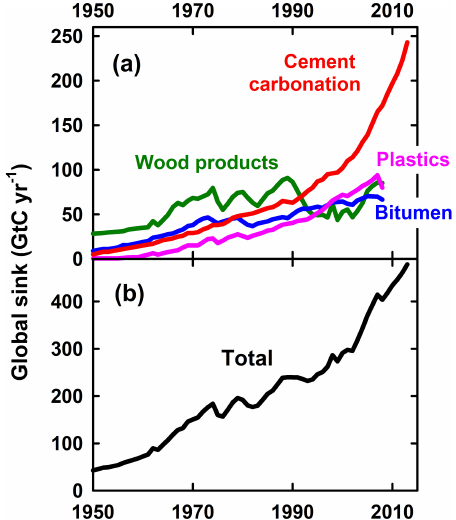
Figure 3. Estimated net fluxes of carbon into the pools of harvested- wood products, plastics, bitumen, and cement carbonation since 1950 (a) and their combined total (b) . Based on data given in Lauk et al. (2012) and Xi et al.